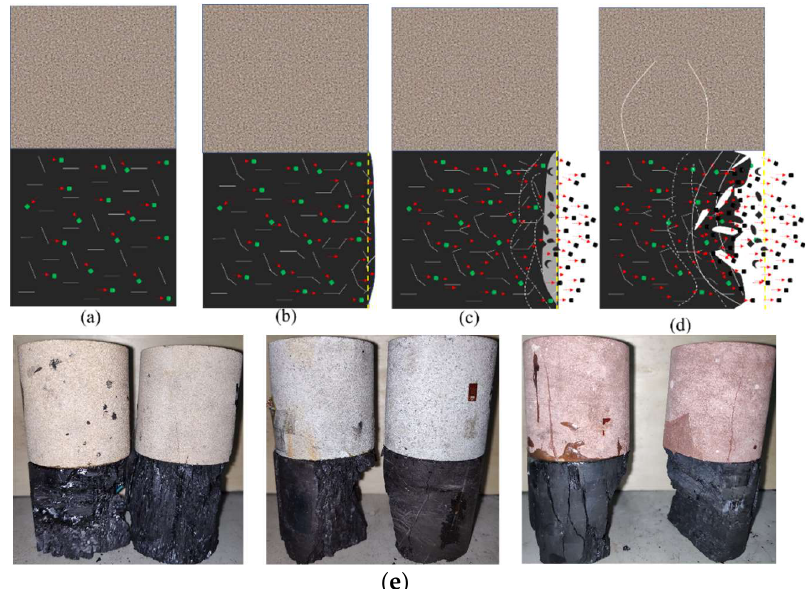
Figure 9. Non-linear energy transfer and release rupture-causing model for coal–rock assemblages. (( a – d ), Incongruous fracture evolution of composite coal rock mass; ( e ) failure modes of composite coal-rock of the experiments)